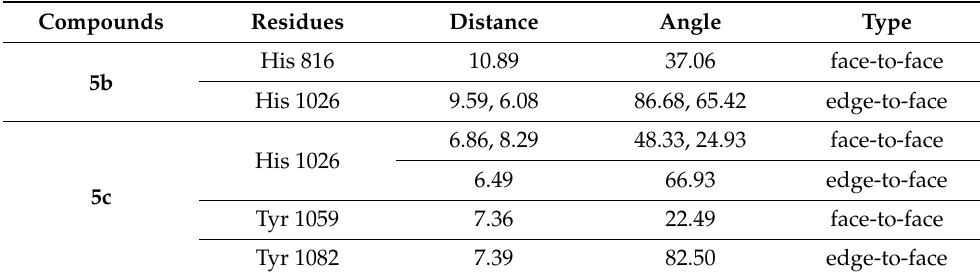
Table 4. Aromatic interactions ( π - π ) between VEGFR-2 and the top-scored compounds. Compounds